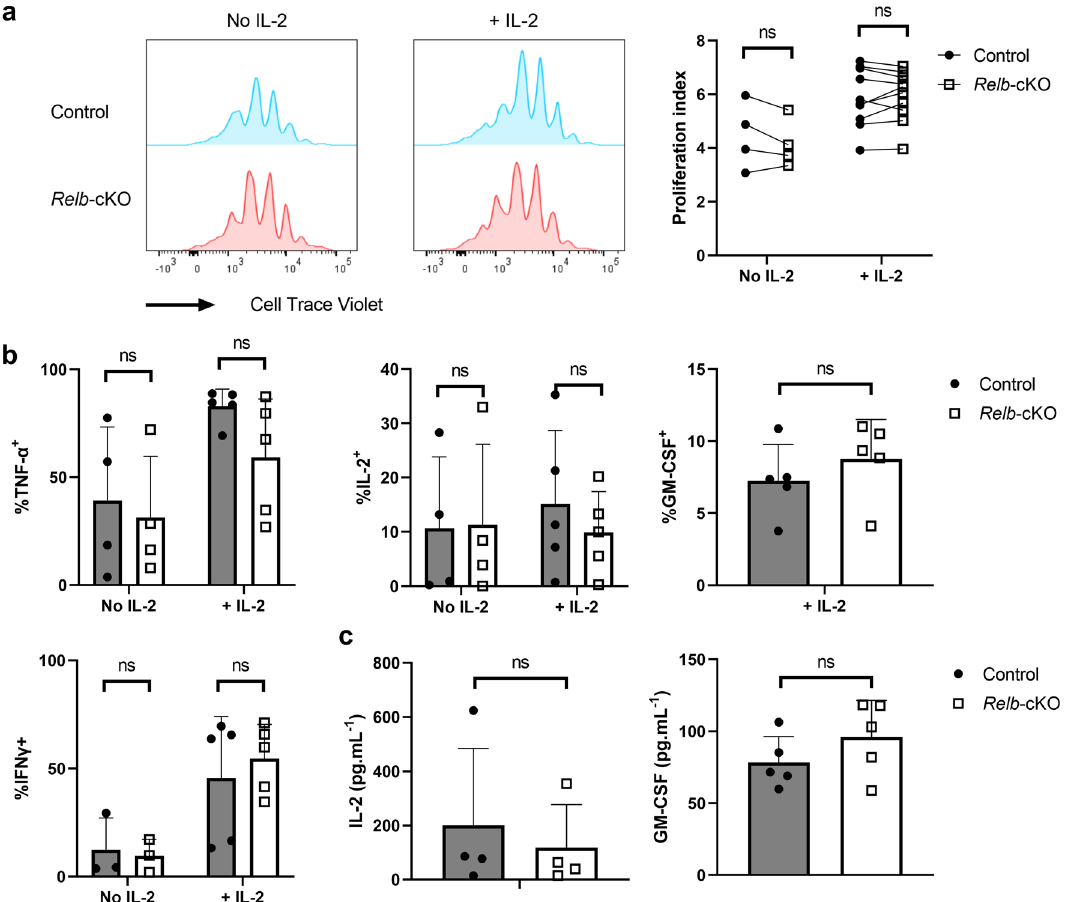
Figure 2. Normal proliferative capacity and cytokine expression of Relb -deficient T cells in vitro. CTV-labeled naïve Tconv cells were stimulated with soluble anti-CD3 + mitomycin C-treated feeders. ( a , b ) After 4 days of culture, cells were restimulated with PMA/ionomycin and analyzed by flow cytometry. ( a ) Representative CTV profile and cumulative proliferation index of live cells. ( b ) Cytokine expression following restimulation with PMA/ionomycin. ( c ) ELISA analysis of supernatants after 24 h of culture. Each dot represents an individual mouse from 5 experiments. Mean + /- SEM is shown. ns :